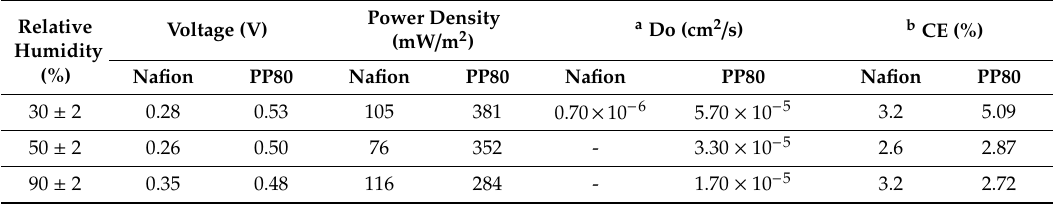
Figure 6. Dissolved oxygen levels noted in a single chamber air-cathode MFC with Nafion 117 ( a ) and PP80 ( b ) at di ff erent relative humidity (RH) conditions. Table 2. Performance parameters of MFC with variations in separator and relative